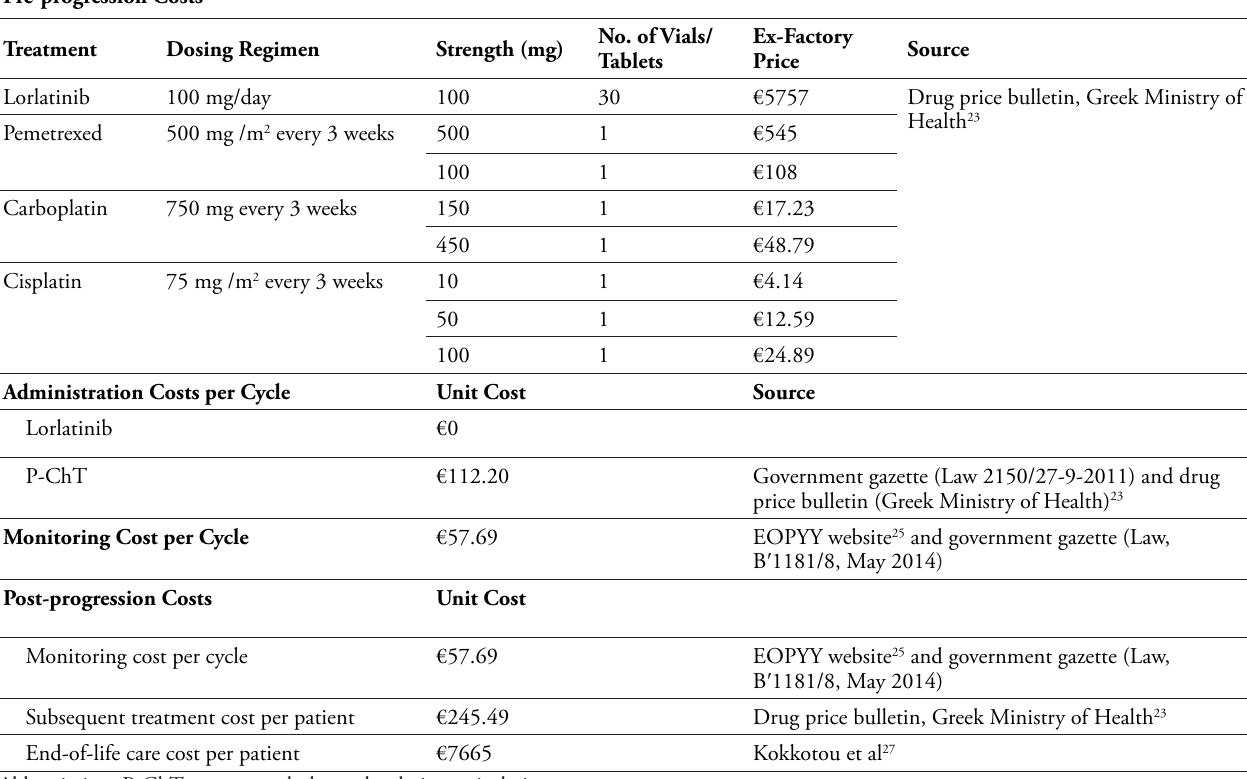
Table 2. Overview of Cost Inputs Considered in the Model